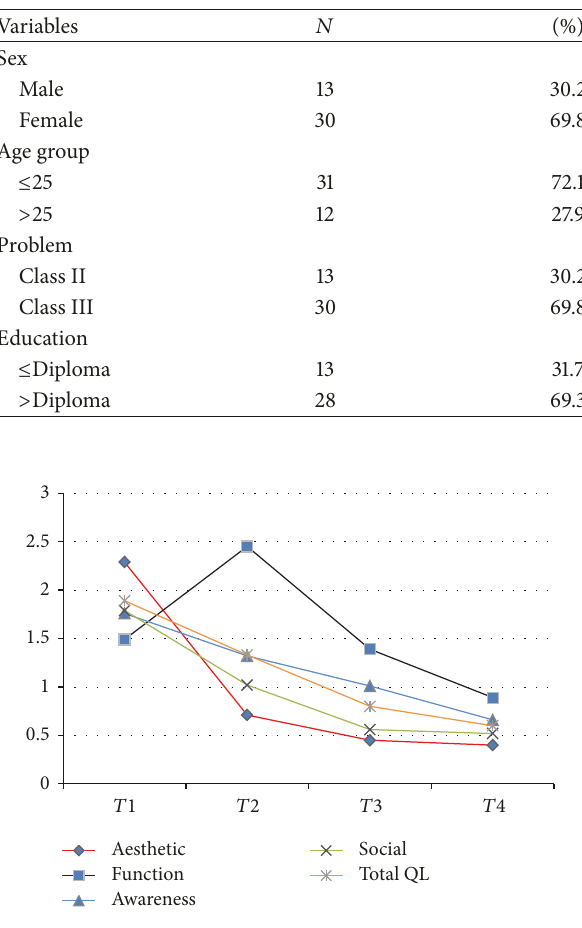
Figure 1: Mean of total OQLQ and subdomains (range 0–4) in different stage of